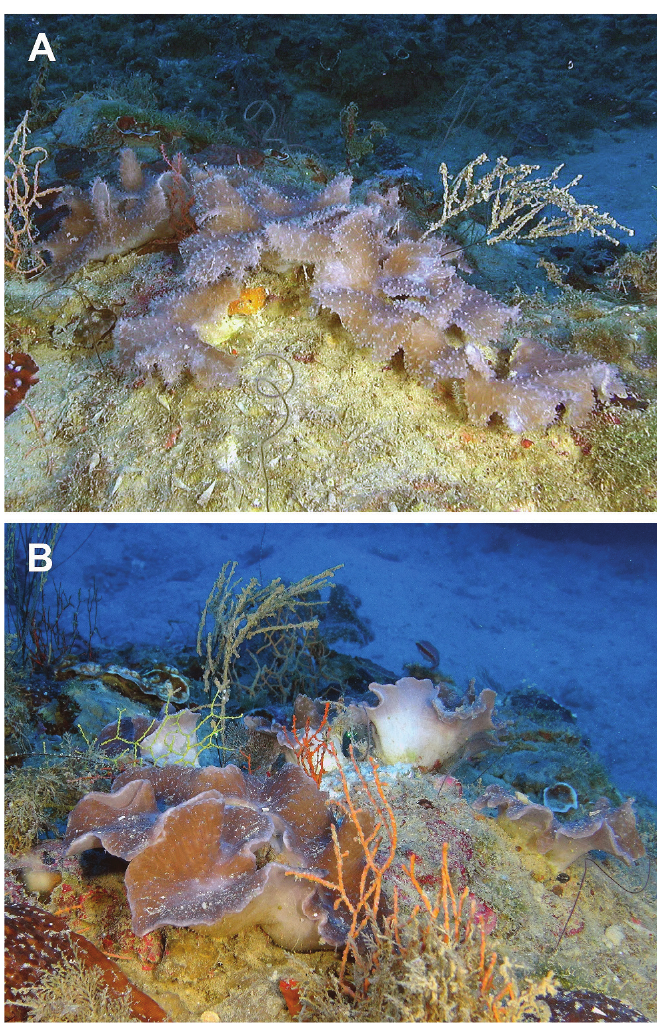
Figure 4. Underwater photographs of Sinularia mesophotica sp. n. A patch of colonies B funnel-shaped morphology of